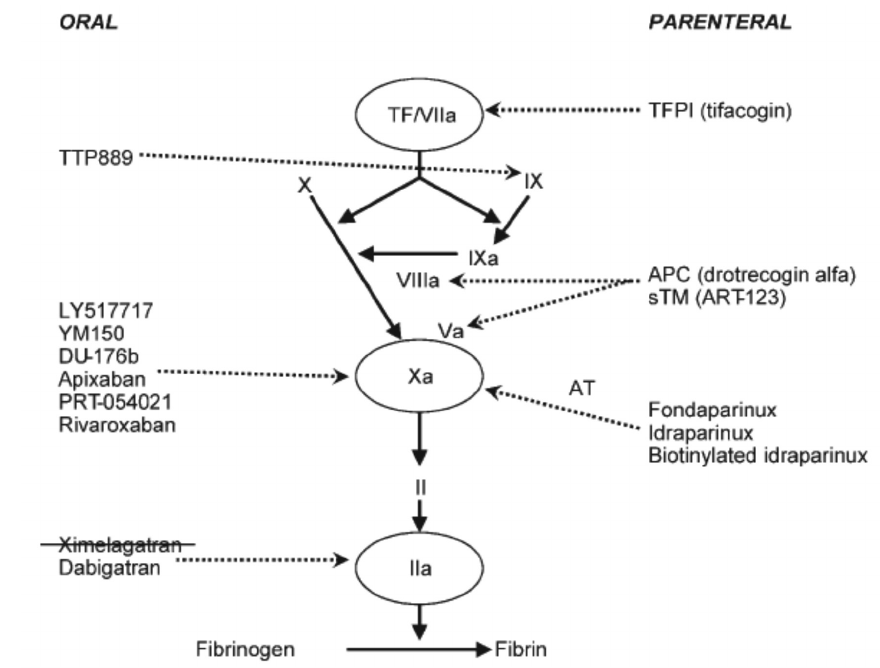
FIGURE 2 - Targets for new anticoagulant drugs in the coagulation cascade (Turpie, 2007).